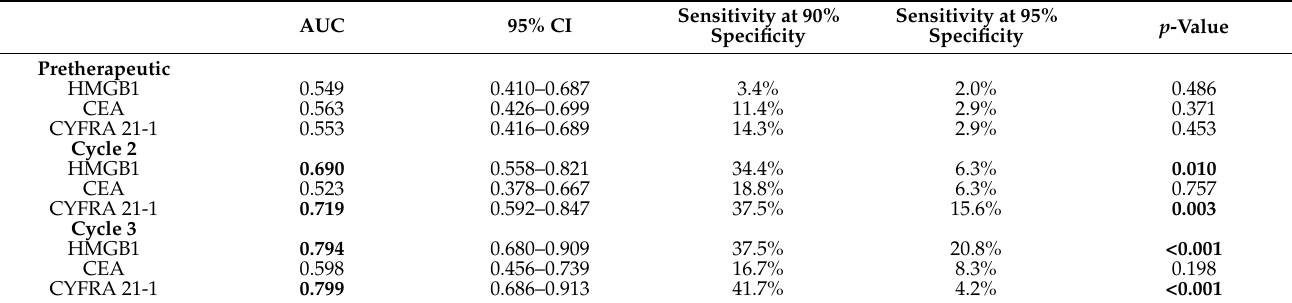
Calculation of Receiver Operating Characteristic (ROC) curve analyses show sensitivity and specificity for prediction/detection of progressive disease of NSCLC patients over the whole spectrum of possible cutoff values. Performance criteria are the area under the curve (AUC) and the sensitivities at specificities of 90% and 95%. p -values in bold indicate statistically significant results.